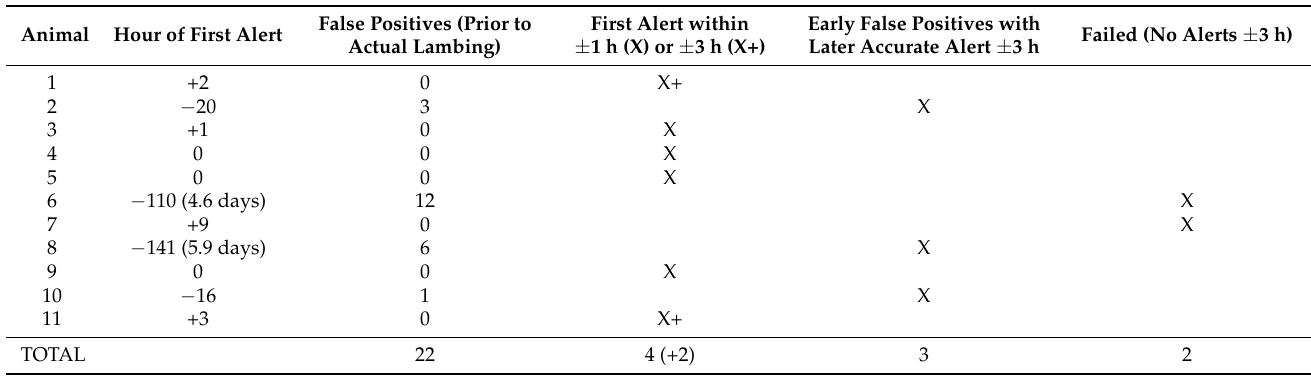
Table 5. Application of the integrated SVM to the validation dataset (Trial Two) with the additional criteria of requiring identification of at least two consecutive “lamb” hours before an alert was generated. Hour of first alert is expressed relative to the recorded hour of birth. Notations “X” and “X+” indicate the animal meets the criteria. Animal Hour of First